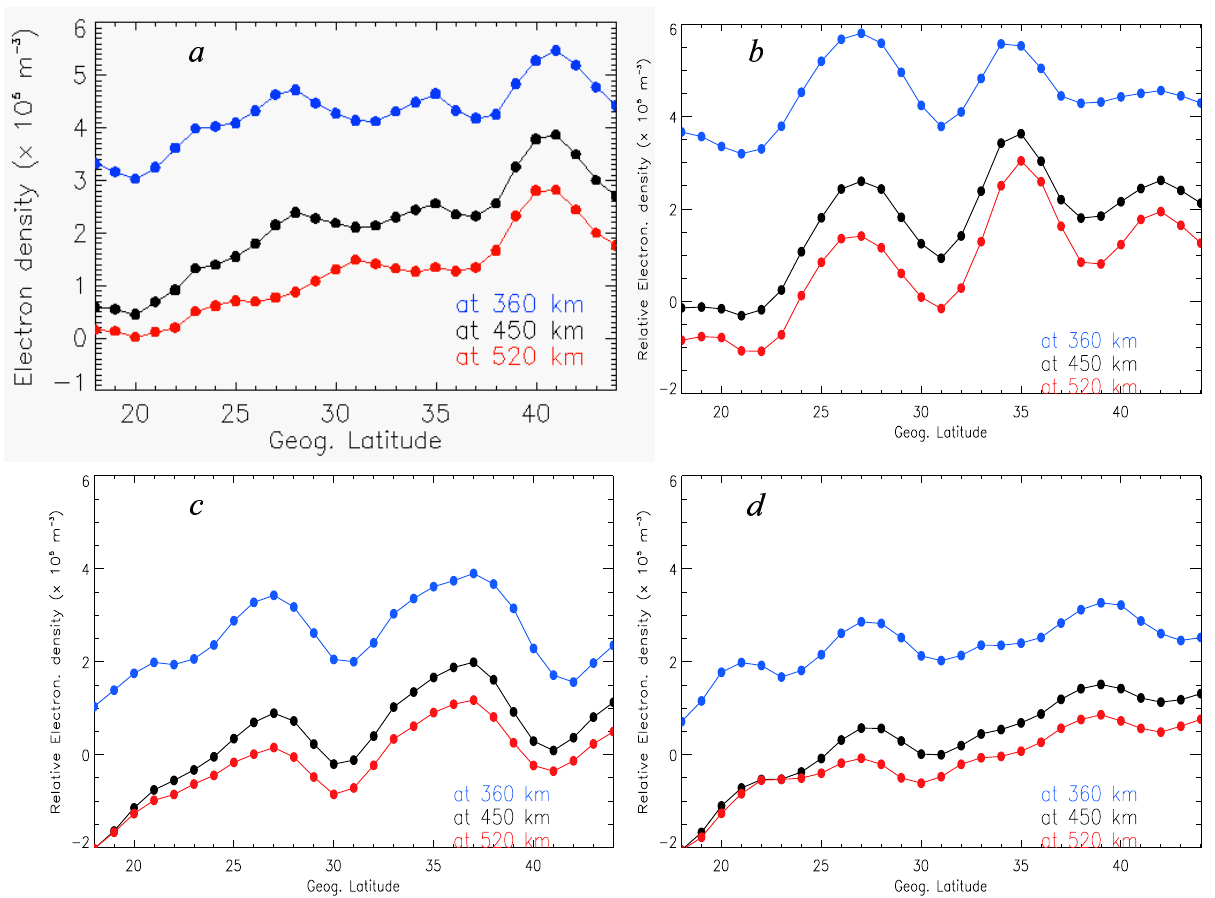
Fig. 12. Variation in the electron density of the tomographic image in Fig. 6 at three different altitudes, 360, 450, and 520km. The background density at each height has been